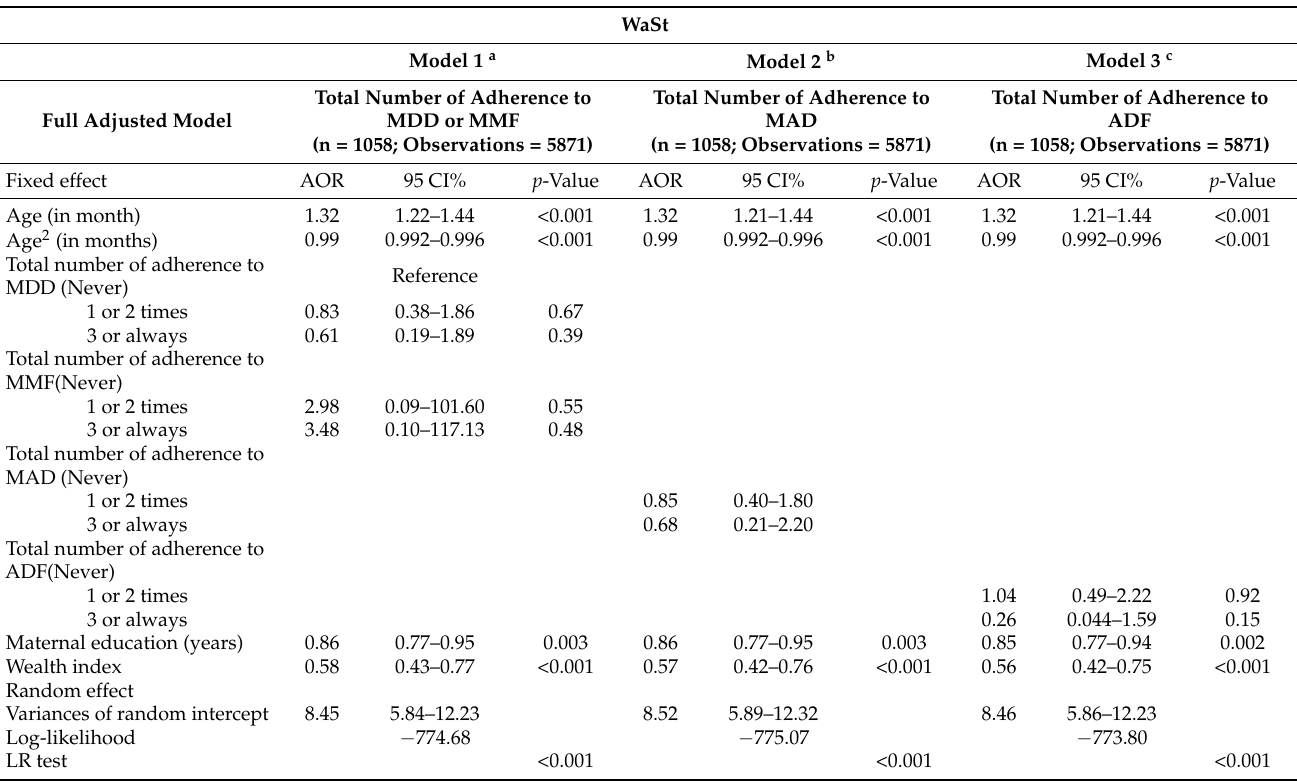
Table 6. The relationship of adherence to age-appropriate feeding practices and other determinants with child concurrence wasting and stunting